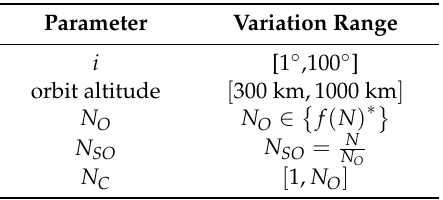
Table 1. The variation range of the parameters defining 2D-lattice flower constellation (2D-LFC) composed of N satellites.